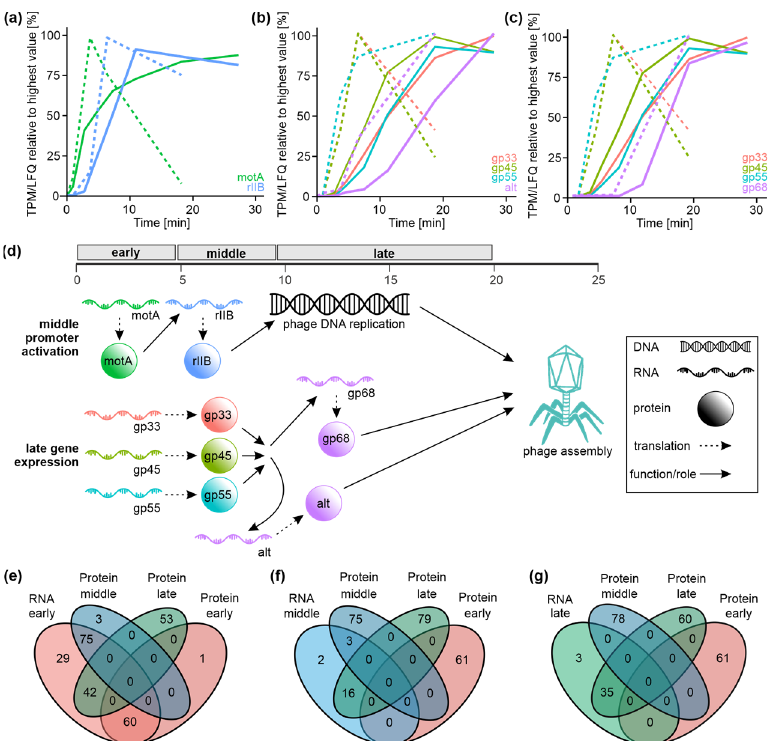
Figure 4. Analysis of correlation of transcriptome and proteome data of T4 phage infection. ( a – c ) Examples of the gene expression regulation during T4 phage infection based on the transcriptome (dashed line) and proteome data (continuous line). ( a ) Example of MotA expression which activates middle transcription of the rIIB gene. ( b , c ) Expression of the activators of late transcription—gp33, gp45 and gp55 triggers late expression of Alt ( b ) and gp68 ( c ). ( d ) Schematic representation of selected gene regulatory cascades during T4 phage infection. A similar color code as shown in ( a – c ) was applied. Infection-phase-specific transcripts and proteins are shown in the order of their appearance during infection based on the data shown in ( a – c ). Arrows indicate the transition between gene regulatory and molecular events. ( e – g ) Venn diagrams displaying overlaps of T4 phage gene classes based on proteome data with either early genes ( e ), middle genes ( f ) or late genes ( g ) derived from transcriptome data